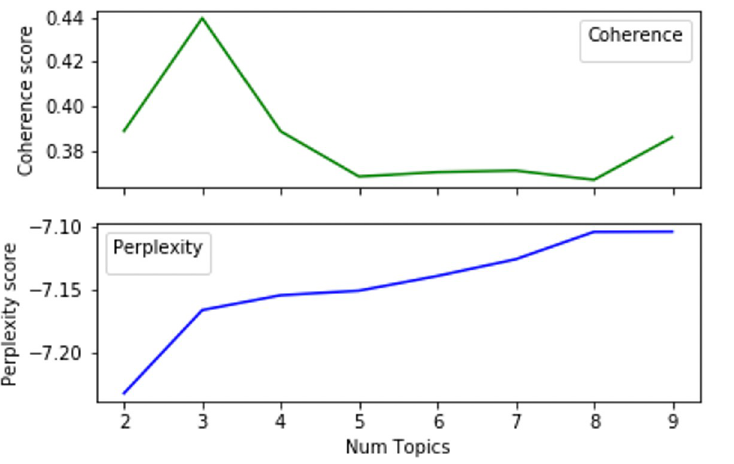
Fig 6. Graph signifying the coherence score performance in comparison to the number of topics for each model. Coherence and Perplexity were calculated at different numbers of topics. Coherence is highest at 3, which indicates that three topics should be used in the model.